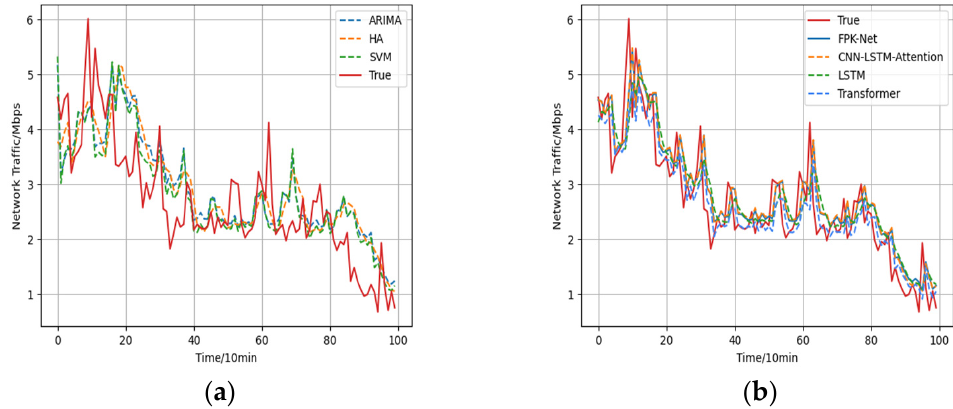
Figure 7. Comparison of prediction results and true values: ( a ) Prediction results of traditional prediction methods vs. true values; ( b ) Prediction results of deep learning models vs. true values.